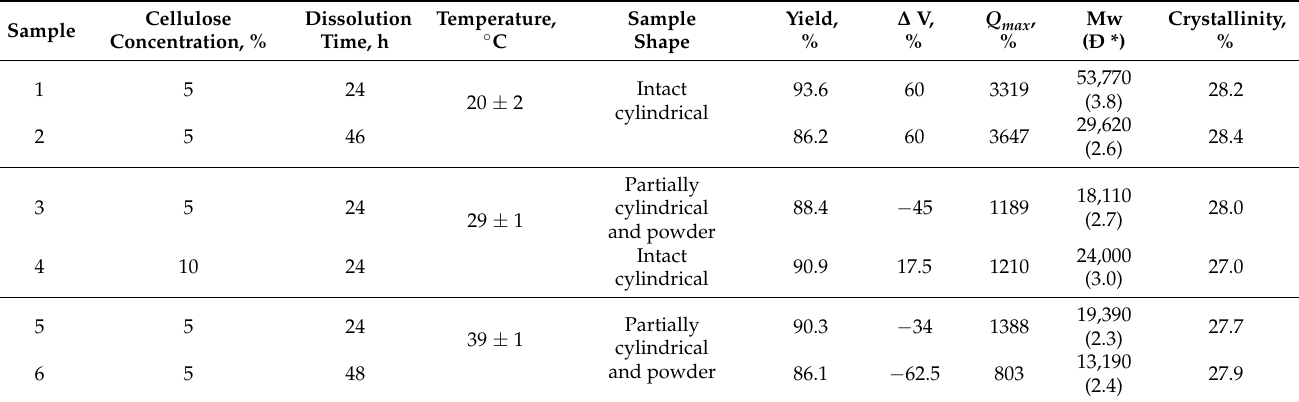
Table 1. Dissolution conditions and characteristics of cellulose